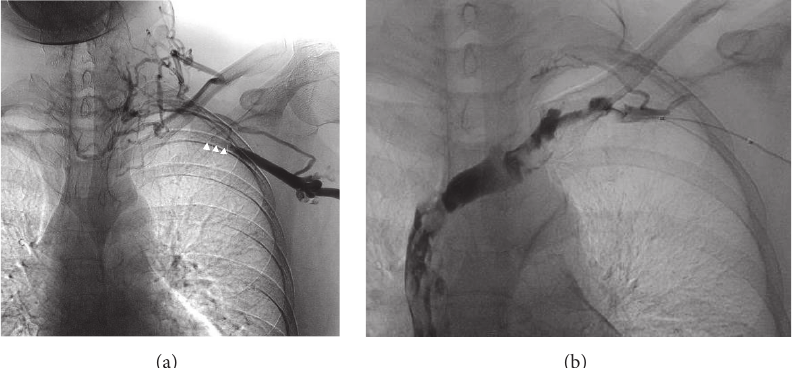
Figure 2: Left subclavian vein angiogram before (a) and after (b) dilation. Blood flow in the left subclavian vein to the left internal jugular vein is interrupted, while inflow of contrast medium is noted into the right subclavian vein via a collateral vessel (arrowhead in (a)). The left subclavian vein is visualized as a contrast-enhanced image after the balloon dilatation